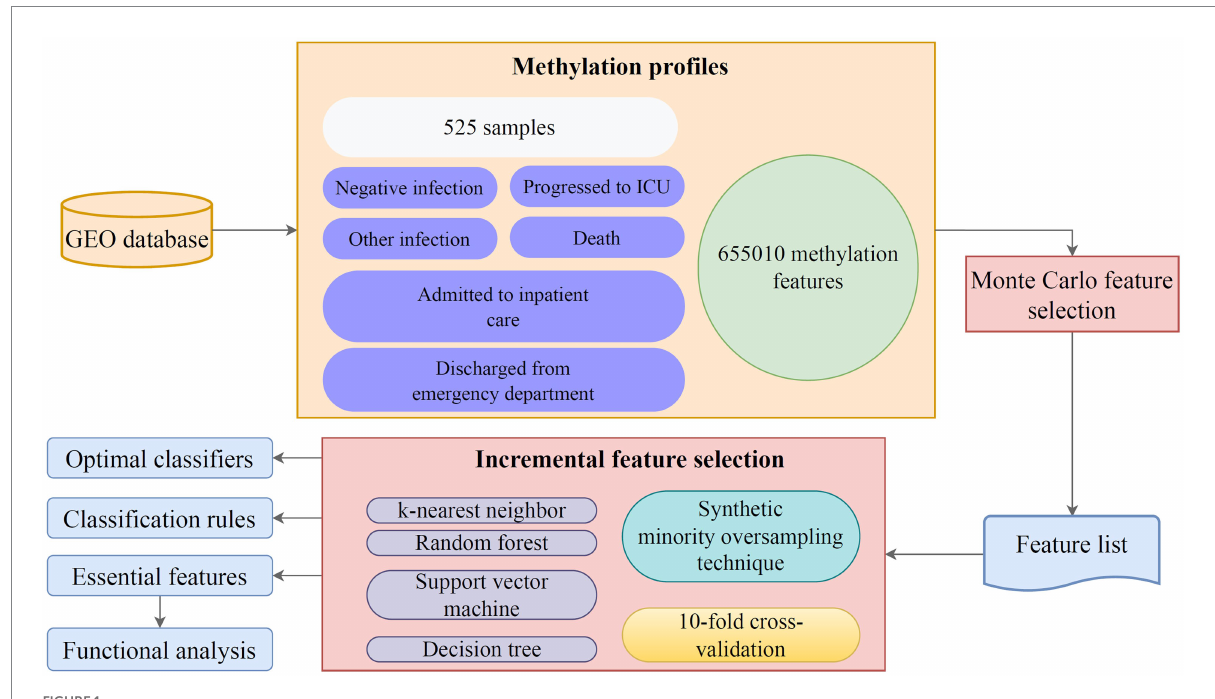
FIGURE 1 Workflow of this study. First, the Monte Carlo feature selection (MCFS) method was used to rank methylation signatures based on their importance, and a ranked feature list was generated. This list was then fed into the incremental feature selection (IFS) method with different classification algorithms to determine the optimal features for each classification algorithm. Optimal classifiers were set up. Classification rules generated by the optimal decision tree (DT) classifier were used to analyze the methylation expression pattern. The genes corresponding to essential methylation sites were subjected to functional enrichment